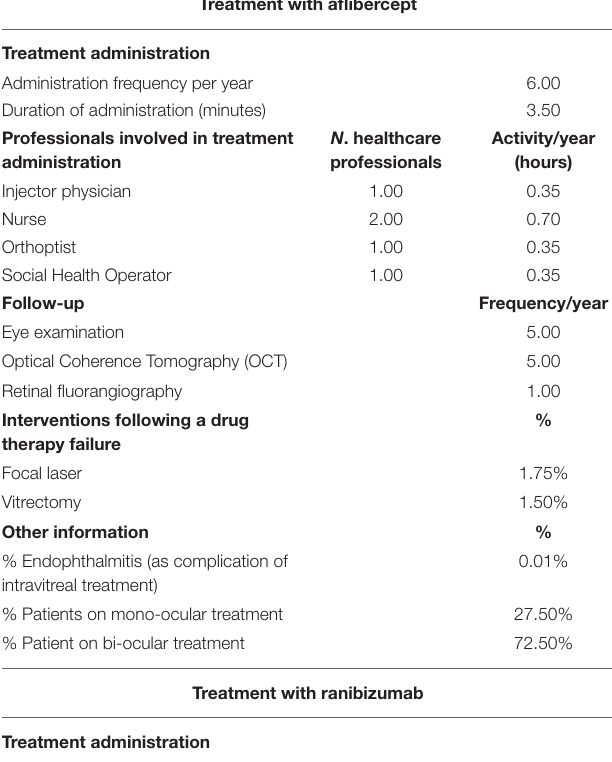
management of DME patients. Treatment with